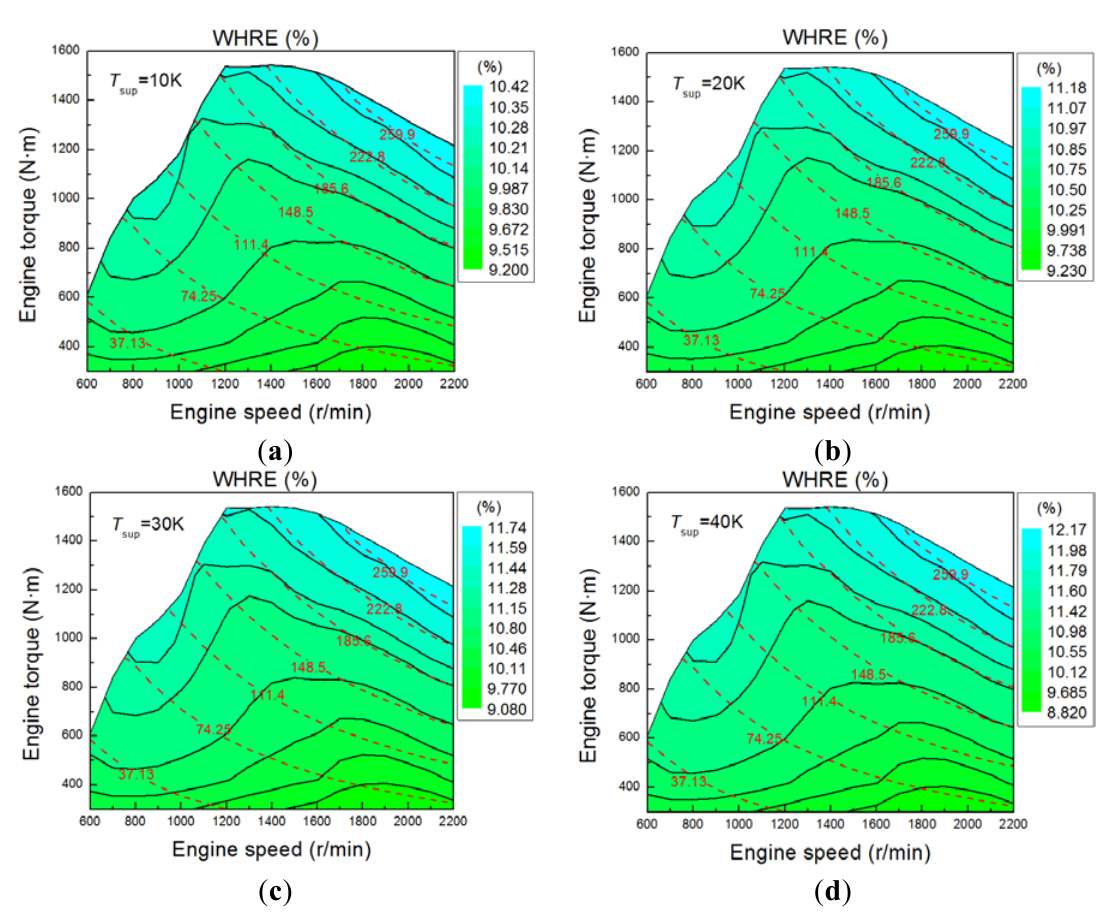
Figure 12. Waste heat recovery efficiency (WHRE) of the ORC waste heat recovery